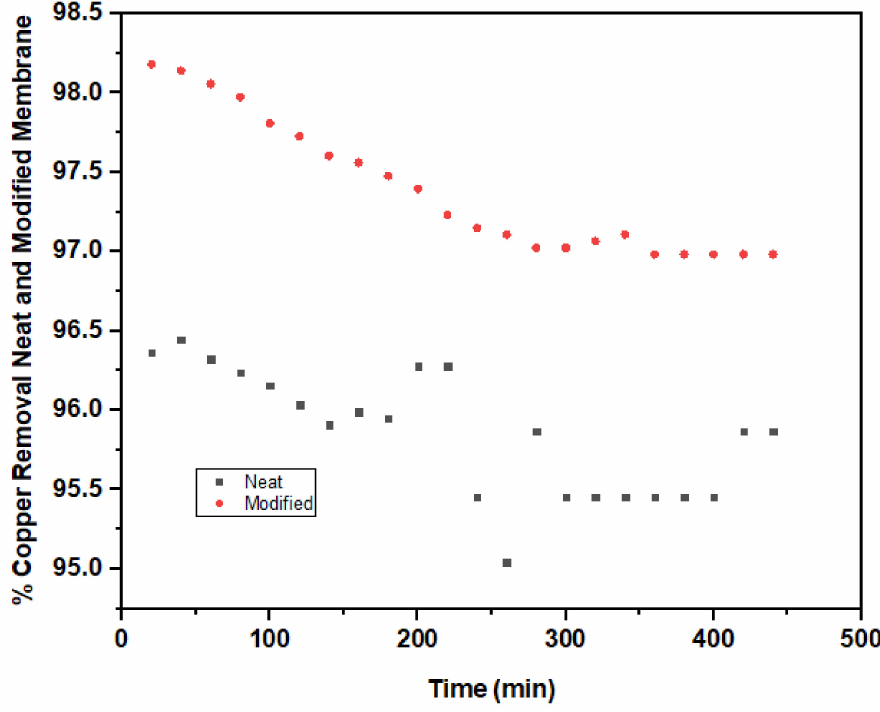
Figure 5. Copper removal by neat (PVDF-PVP) and modified (1.0 wt% TiO 2 )